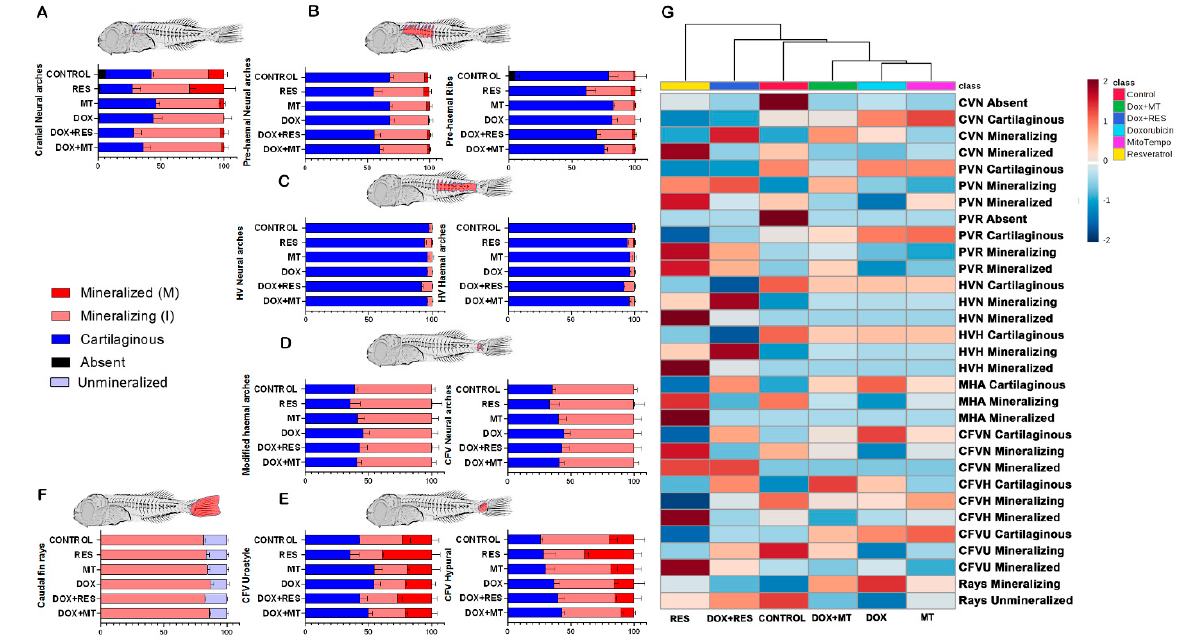
Figure 6. Developmental status and mineralization patterns of gilthead seabream fed different microdiets. Percentage of mineralized, mineralizing, cartilaginous, unmineralized and absent; cranial vertebrae neural arch ( A ), prehaemal vertebrae neural arches and ribs ( B ), haemal vertebrae neural ( C ), modified haemal arch and caudal vertebrae neural arches ( D ), caudal fin vertebrae (CFV), urostyle and hypural ( E ), and caudal fin rays ( F ). Heat map of mineralization pattern of skeleton element between the antioxidant and pro-oxidant supplemented groups ( G ). Graph: percentage +/ − SEM. Acronyms: resveratrol (RES), doxorubicin (DOX), MitoTEMPO (MT), doxorubicin + resveratrol (DOX+RES) and Doxorubicin + MitoTEMPO (DOX+MT), Cephalic vertebrae neural arches (CVN), Pre-haemal vertebrae neural arches (PVN), Pre-haemal vertebrae ribs (PVR), Haemal vertebrae neural arches (HVN), Haemal vertebrae haemal arches (HVH), Caudal vertebrae Modified haemal